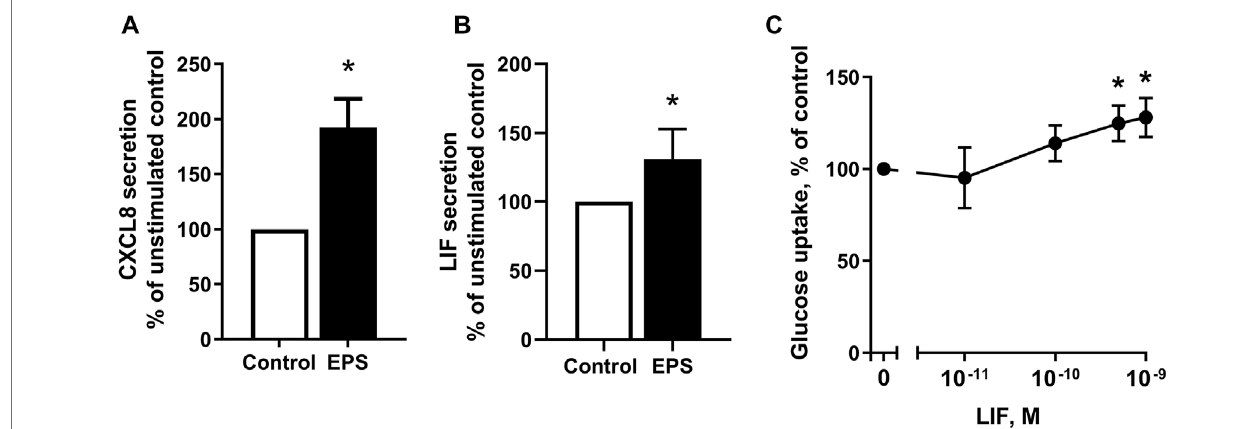
FIGURE 7 | Detection of myokines in conditioned media following electrical pulse stimulation (EPS protocol 2) for 48 h and effect of leukemia inhibitory factor (LIF) on glucose uptake. (A,B) Human myotubes from middle-aged women and men were cultured and EPS protocol 2 was applied before conditioned media were harvested. The concentrations of CXCL8 (A) and LIF (B) in media were determined by ELISA and multiplex immunoassay, respectively. Data are expressed as mean ± SEM, normalized to media from non-treated control cells (absolute values: IL-8; 3 ± 0.07 pM. and LIF; 1 ± 0.03 pM.) (C) Myotubes from the same subjects were incubated in buffer with 2-[ 3 H(G)]deoxy- D -glucose (1 μ Ci/ml, 10 μ M) and various concentrations of LIF (0.01 – 1 nM) and uptake of deoxyglucose was measured for 15 min as described in Materials and Methods. All data are shown as normalized to unstimulated control cells from six ( n = 6, (A,B) and nine ( n = 9, (C) individual experiments. *p < 0.05 vs.